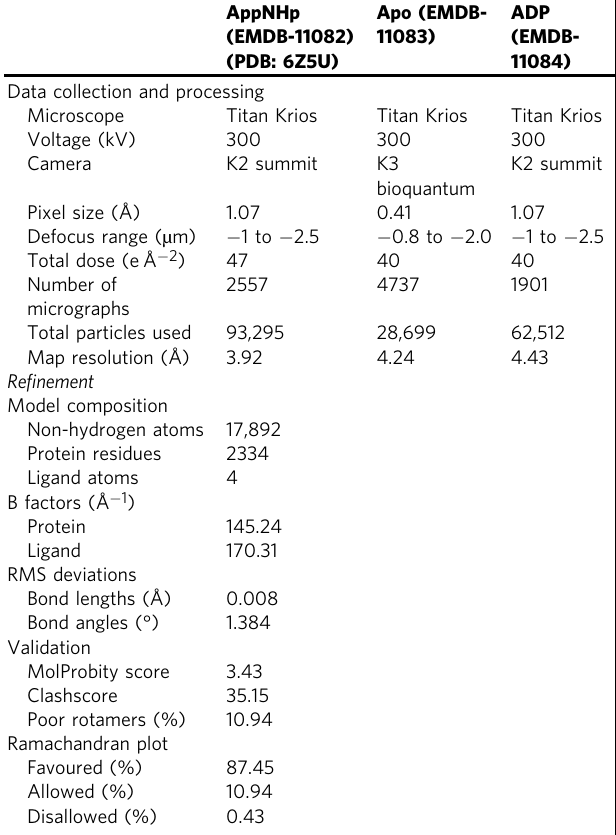
Table 1 Cryo-EM data processing and re fi nement statistics.